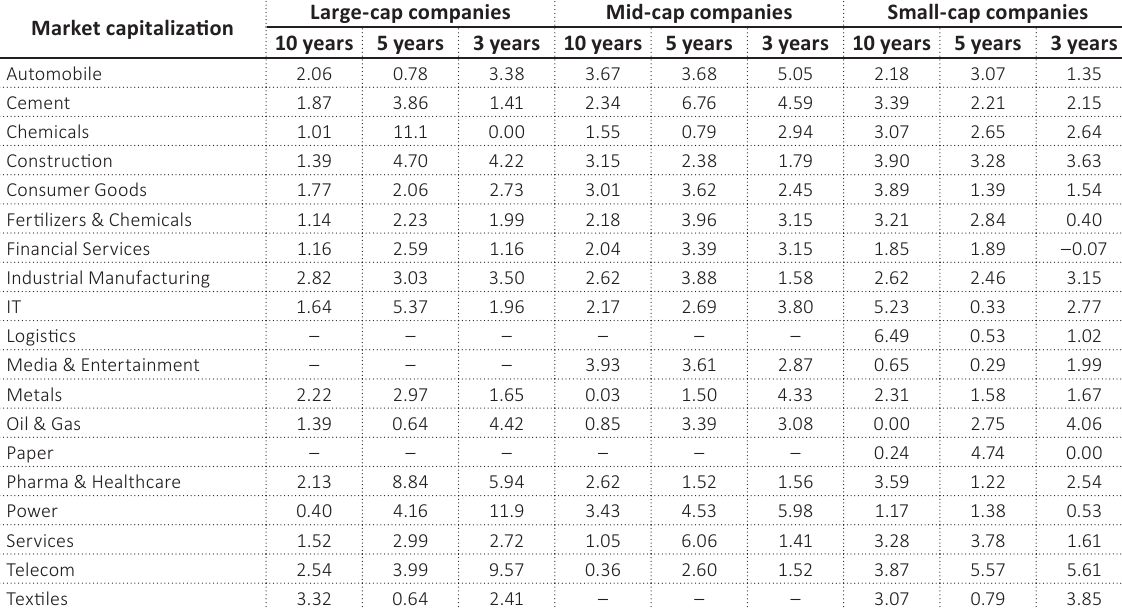
Table 3. Mean excess return (VA XIRR – SIP XIRR), in percentage points according to